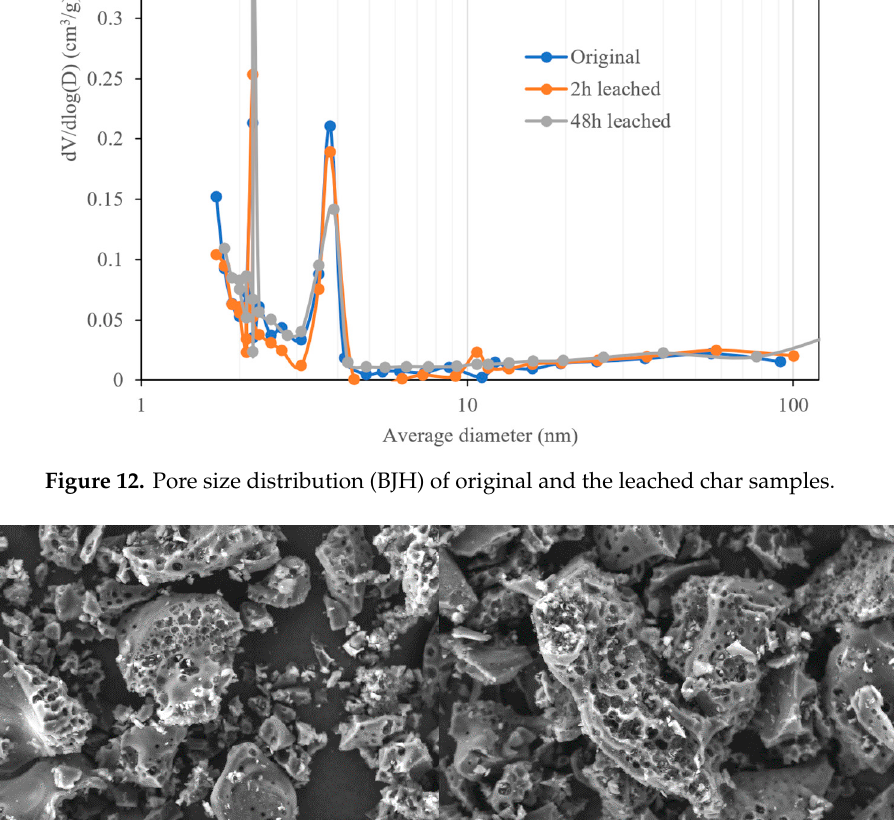
Figure 13. SEM images of 2LC and 48LC.